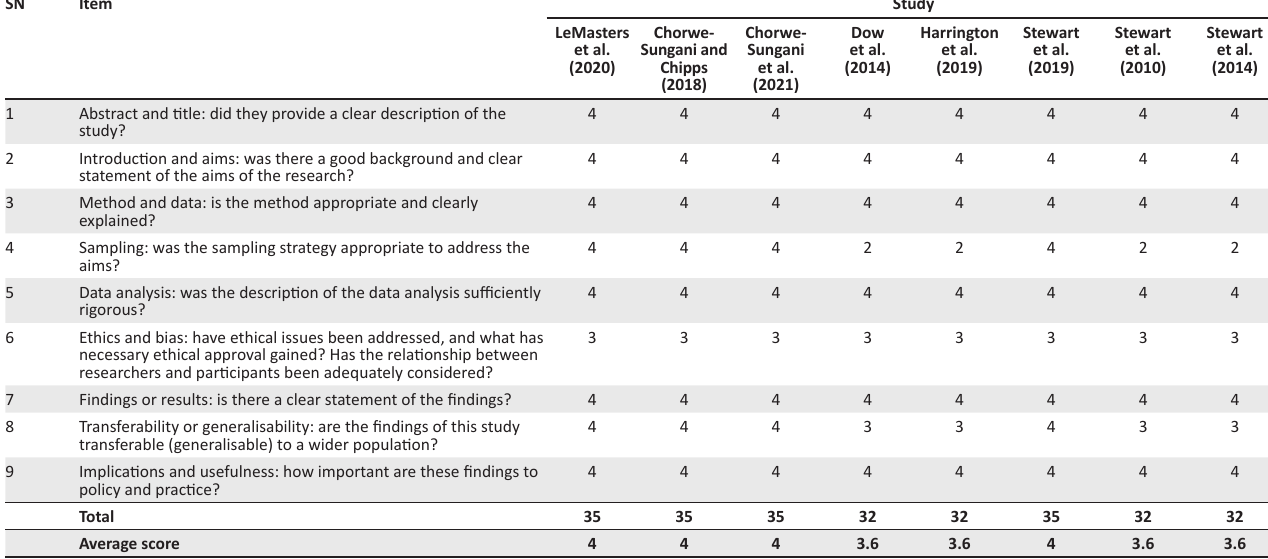
TABLE 2: Methodological quality of studies.